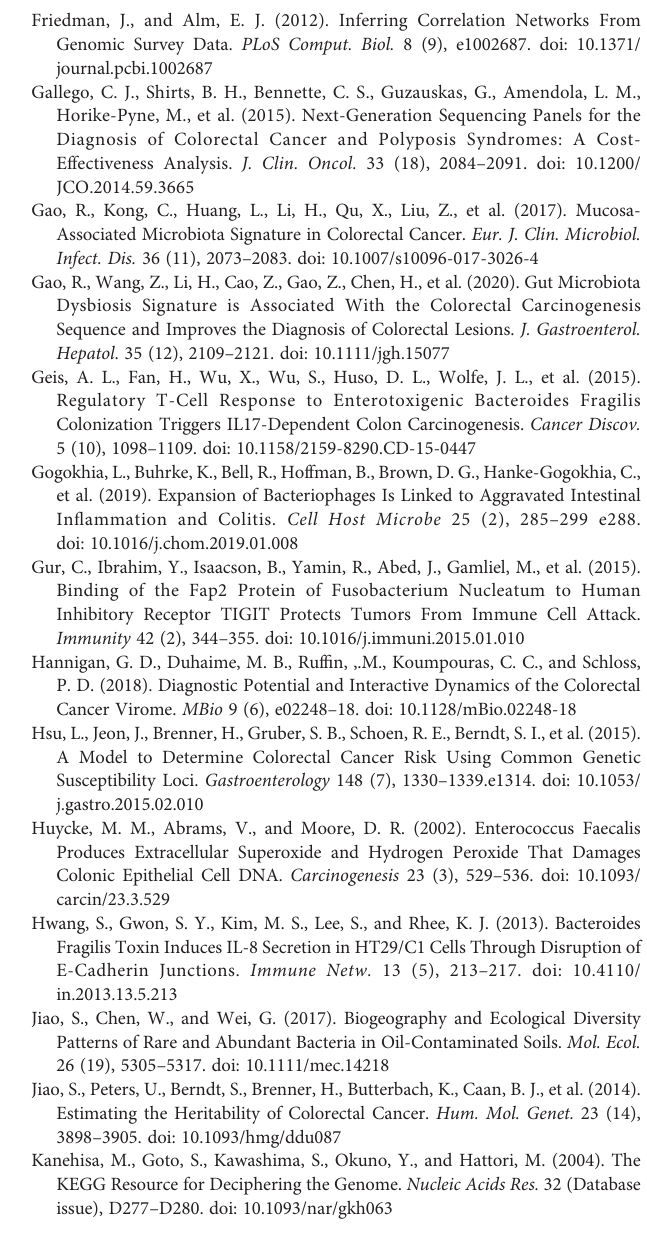
Supplementary Figure 7 | Bacteria and viruses selected for diagnostic models for colorectal cancer. (A) . The top 5 bacteria and viruses were chosen to diagnose colorectal cancer in Hong Kong and Japanese cohorts. (B) . Top 12 bacteria and viruses selected for the ROC of diagnosis of colorectal cancer in Hong Kong, Japanese, and Shanghai cohorts. Supplementary Table 1 | The characteristics of enrolled subjects in this study (Mean ± Standard Deviation). *One patient had two cancers in both ascending colon and rectum, which was counted in both ascending colon cancer and rectal cancer. A, Ascending colon; T, Transversal colon; D, Descending colon; S, Sigmoid colon; R, Rectum. # Mean ± Standard error of the mean (SEM). WBC, White blood cell; RBC, Red blood cell; ALT, Alanine transaminase; AST, Aspartate aminotransferase; CEA, Carcinoembryonic antigen; AFP, Alpha-